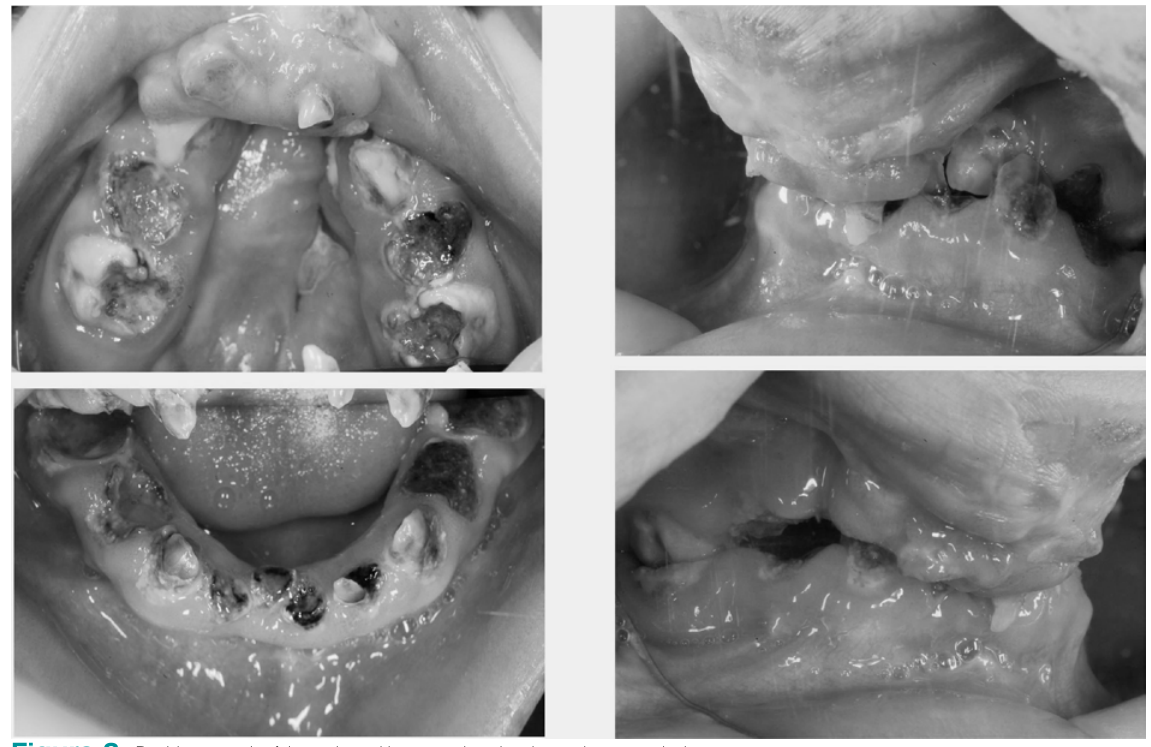
Figure 2. Deciduous teeth of the patient with severe dental caries and